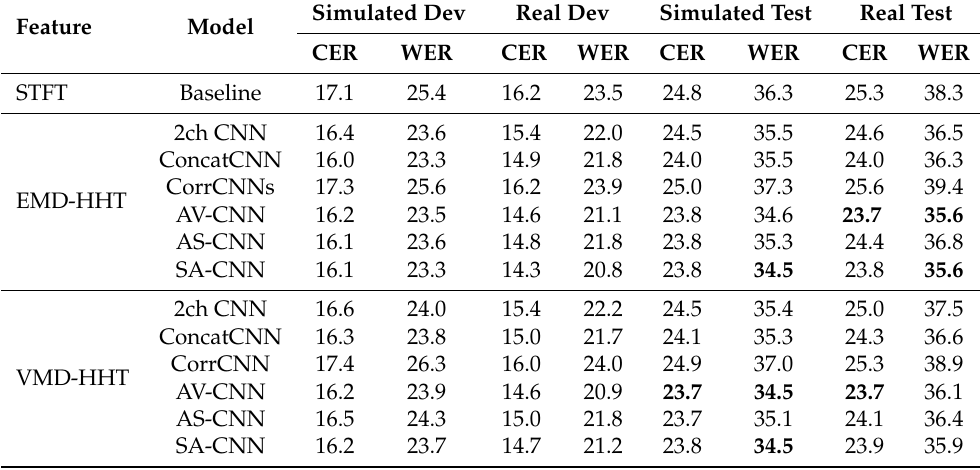
Table 5. CER and WER results (%) of clean and noisy tests for all the models trained on the CHiME-4 dataset (The best results for each set are highlighted with bold